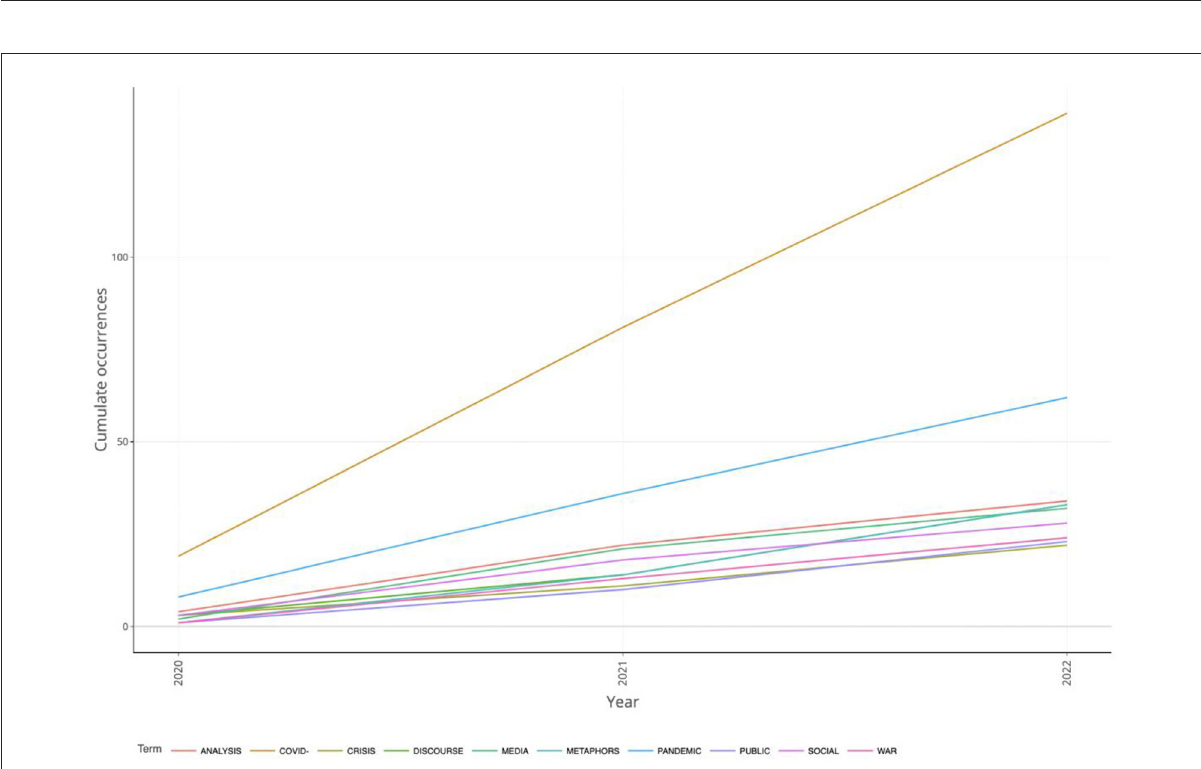
FIGURE9 A word dynamic plot of the most frequent unigrams of research